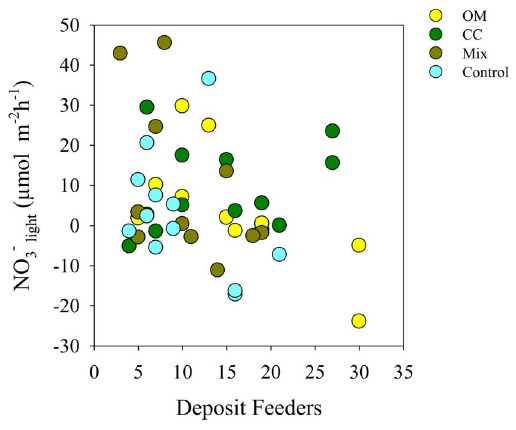
Figure 4. Relationship between nitrate flux during daylight ( m mol NO 3 2 light m 2 2 h 2 1 ) and the abundance of deposit feeders. The panel shows the general relationship across the sampling area. Plots are raw data. (Treatments: Organic Matter, Calcium carbonate, Mix, Control).